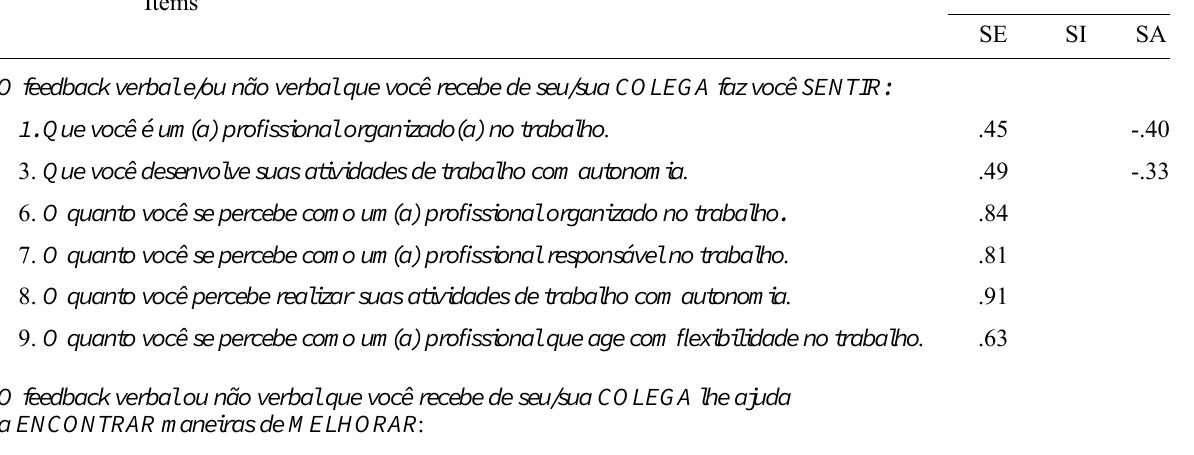
Items and Factor Loadings of the Exploratory Version of the WR-SRPS - Coworker